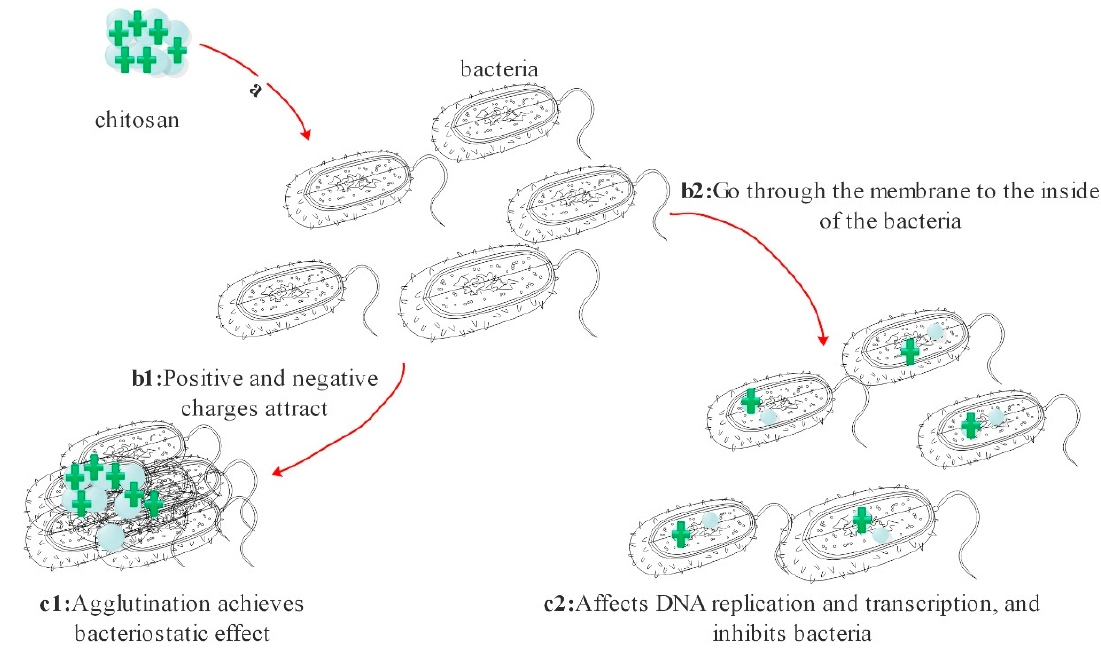
Figure 7. Two different antibacterial mechanisms of chitosan ( a . Chitosan is covered on the wound. b1 , c1 . Cations cause bacteria to accumulate. b2 , c2 . effect on bacterial reproduction).